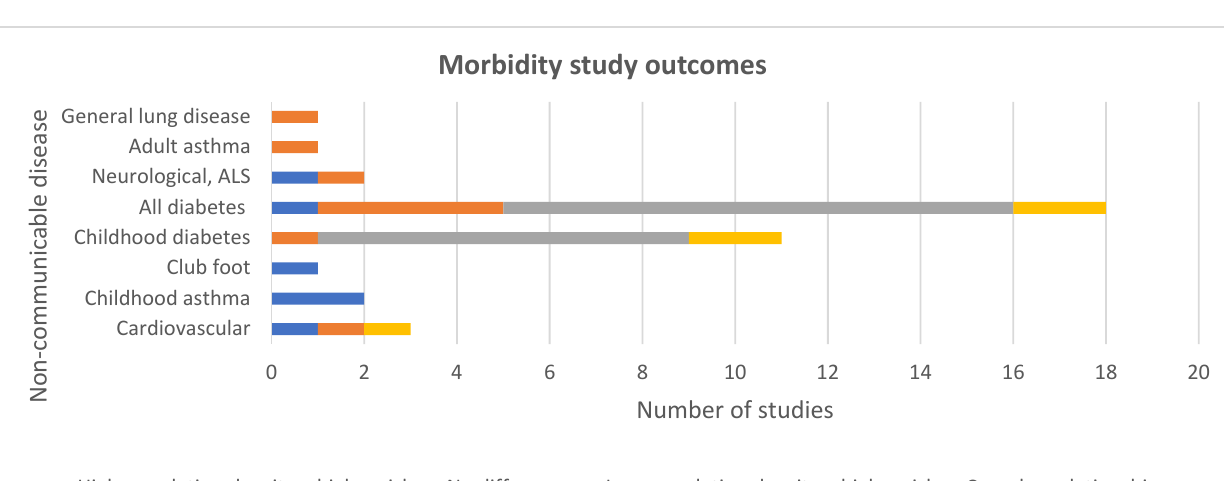
Figure 5. Cancer-specific morbidity study outcomes.